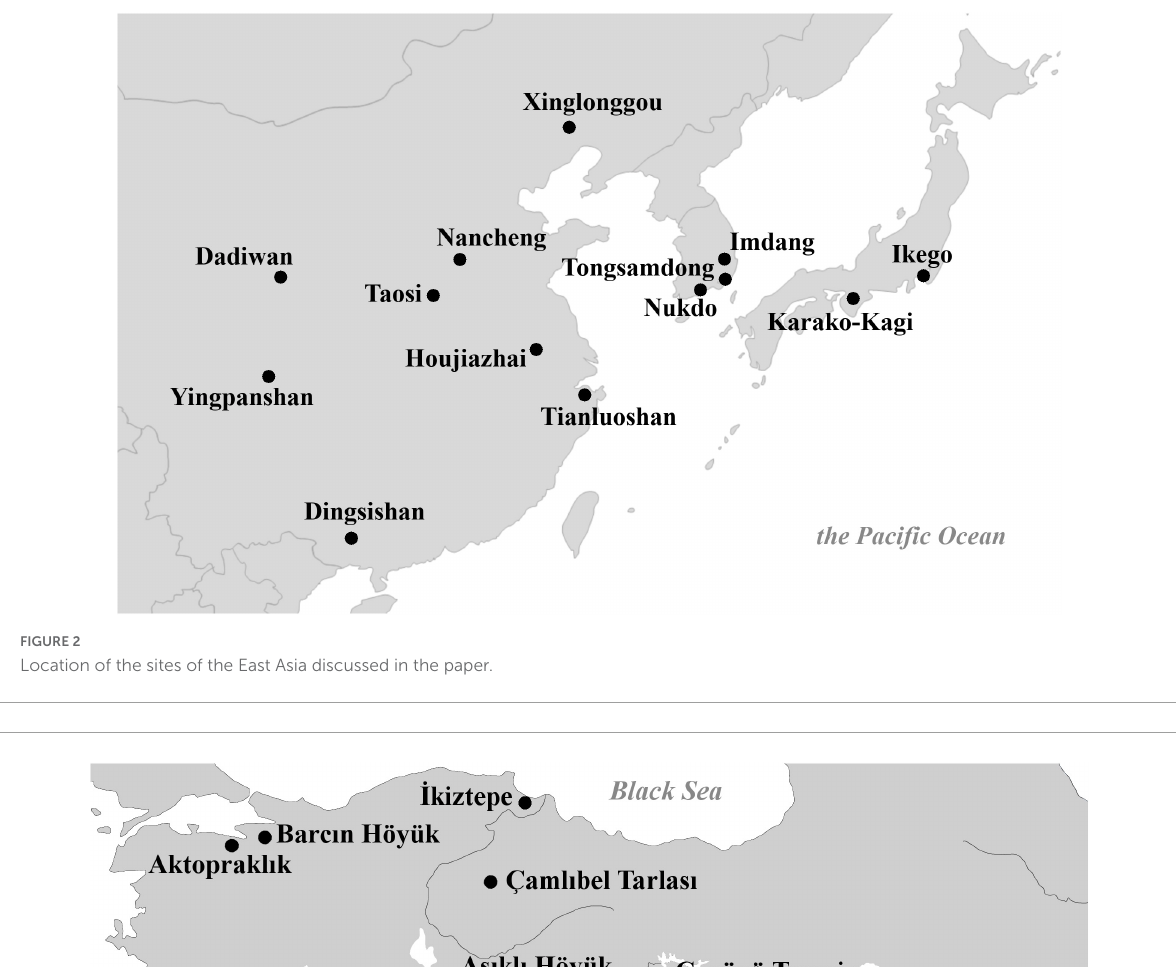
FIGURE2 Location of the sites of the East Asia discussed in the paper.